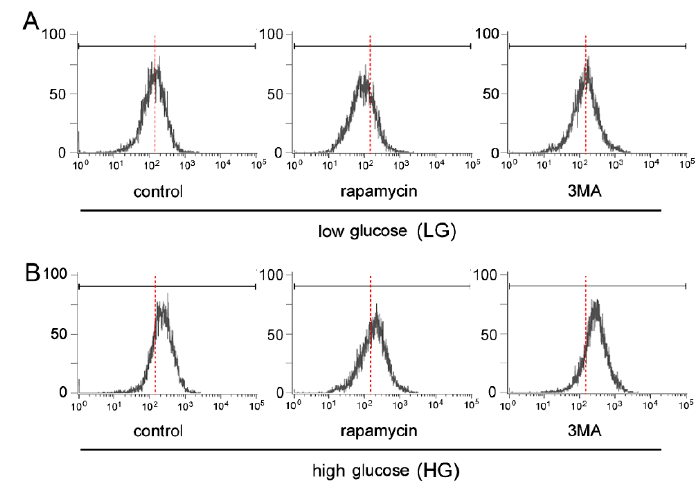
Figure 3. Intracellular superoxide formation by 661 W cells cultured under low glucose ( A ) and high glucose ( B ) conditions. Flow cytometric analyses of superoxide formation under each condition. Vertical axis represents the cell numbers and horizontal axis represents the ethidium fluorescein intensities. The red dotted lines indicate the mean fluorescein intensity of the LG control level. Fluorescence intensity was higher under HG control than LG control, indicative of increased superoxide formation under HG condition. Addition of 3MA, an inhibitor of autophagy, caused a further rightward shift under HG condition ( B ), while this e ff ect was absent under LG condition ( A ). Rapamycin, an inducer of autophagy, slightly decreased the fluorescence intensity from the control under LG condition ( A ), while the e ff ect was not seen under HG condition ( B ).